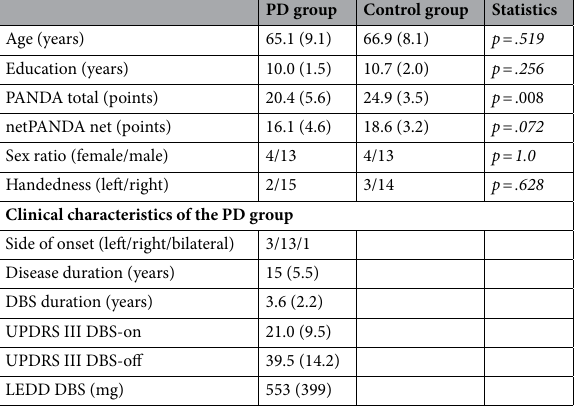
Table 1. Demographic and clinical sample characteristics. Values are the mean with standard deviations in brackets. PANDA scores were raised in the DBS-on state of persons with PD. PANDA Parkinson